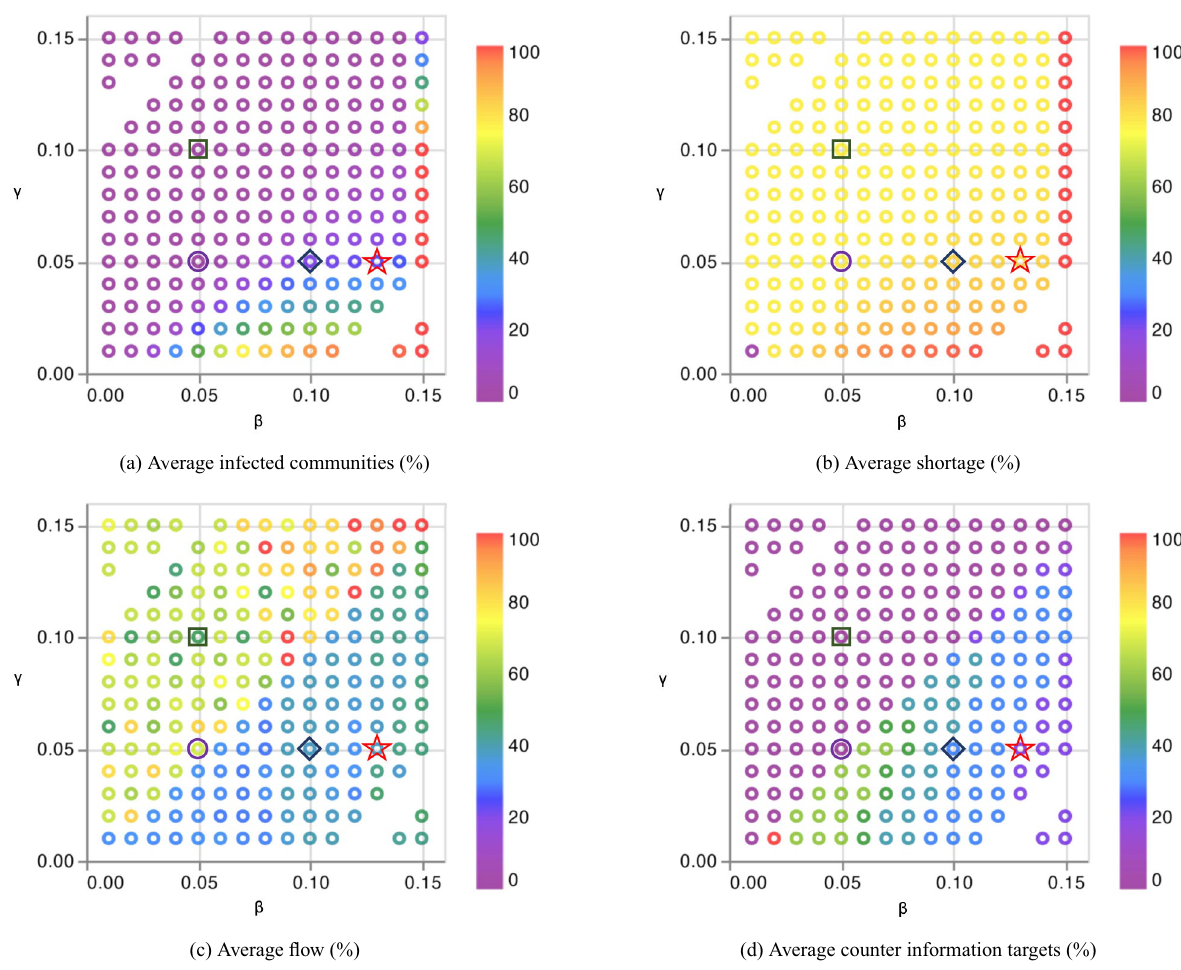
Figure 2. The results of ( a ) average infected communities, ( b ) average shortage, ( c ) average flows, and ( d ) average counter information targets with different combinations of β and γ as percentage of the baseline Based on the estimated usage of social networks in 2021 87 , it is assumed that 82% of the population in each block group have active access to social networks, so they are potentially susceptible to being targeted by disin- formation. To run the disinformation propagation model, we considered 1% population being targeted by disin- formation at the beginning of the analysis time period. As time goes on, the proportion of susceptible, infected (targeted) and recovered users changes according to the contact rate, the rate of being targeted by disinformation, and the rate of being aware of disinformation. The topology of the power distribution network and the community layer are integrated as a one-to-many setting such that many block groups are assigned to one and only one power bus based on their shortest Euclidean distance to the set of power bus candidates. In other words, the population in block groups is clustered such that the locations of power buses are set as the mean of population clusters. We interpret the parameters β and γ as the rate of disinformation degree of interest and the rate of aware- ness, respectively. A higher value of β results in a higher number of people targeted by disinformation per time period. The higher the value of γ , the larger the number of people who become aware of disinformation after being targeted per time period. We analyzed the sensitivity of the solutions for different values of β and γ , as shown in Fig. 2. In these graphs, the ideal condition for β and γ is in the upper left corner of the figures, where the rate of degree of interest takes on the lowest value and the awareness rate is set to its highest value. On the other hand, the worst case is where β is relatively higher and γ is relatively lower, which is located in the lower right corner of the figures. We ran the model with respect to several different instances of the values β and γ to analyze the sensitivity of the total shortage, the total number of communities targeted by counter information, the total flow, and the total infected communities. The results are normalized to show the percentage of differ- ence in the resulting values. To measure the potential spread of disinformation between social media users, the basic reproduction number ( R 0 i = β γ ) is used. It reveals the expected number of secondary susceptible users that a targeted user can affect with disinformation. For example, given R 0 i = 20 , each newly targeted user is expected to affect 20 secondary users within the community i , assuming that all other users contacted are susceptible. To eliminate disinforma- tion or decrease the number of targeted users, the basic reproduction number should satisfy R 0 i < 1 , otherwise